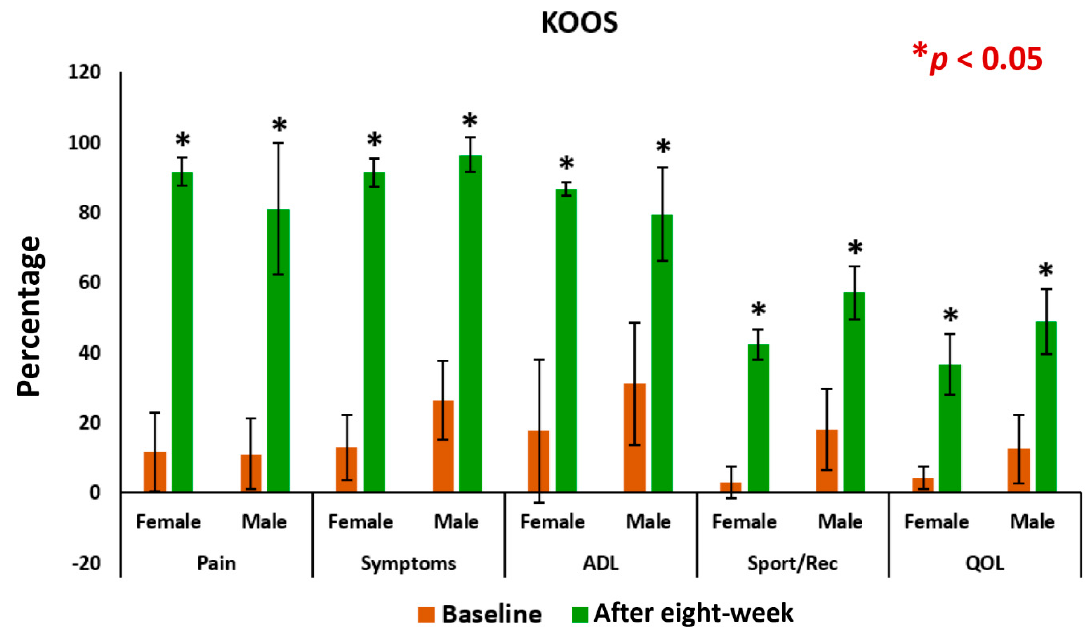
Figure 8. Analysis of knee-injury osteoarthritis outcome scale of 63 experimental subjects, female ( n = 39) and male ( n = 24), before and after eight-week with supplement (* p < 0.05), ADL: Activities of daily living; QOL: Quality of life